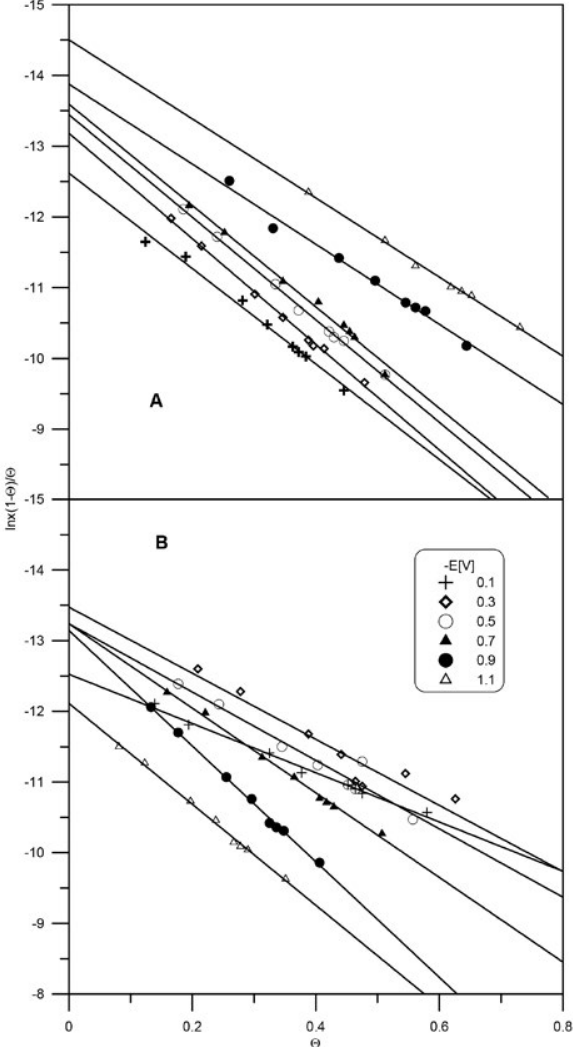
Figure 6. Linear test of the Frumkin isotherm in the system acetic buffer pH 3 (A) and pH 4 (B) + adenine for different electrode po- tentials. ...Values Table 2. The constants of Frumkin (F) and virial (V) isotherms for the system: the acetic buffer pH 3 and pH 4 + adenine; E, – Δ G 0 , B. pH